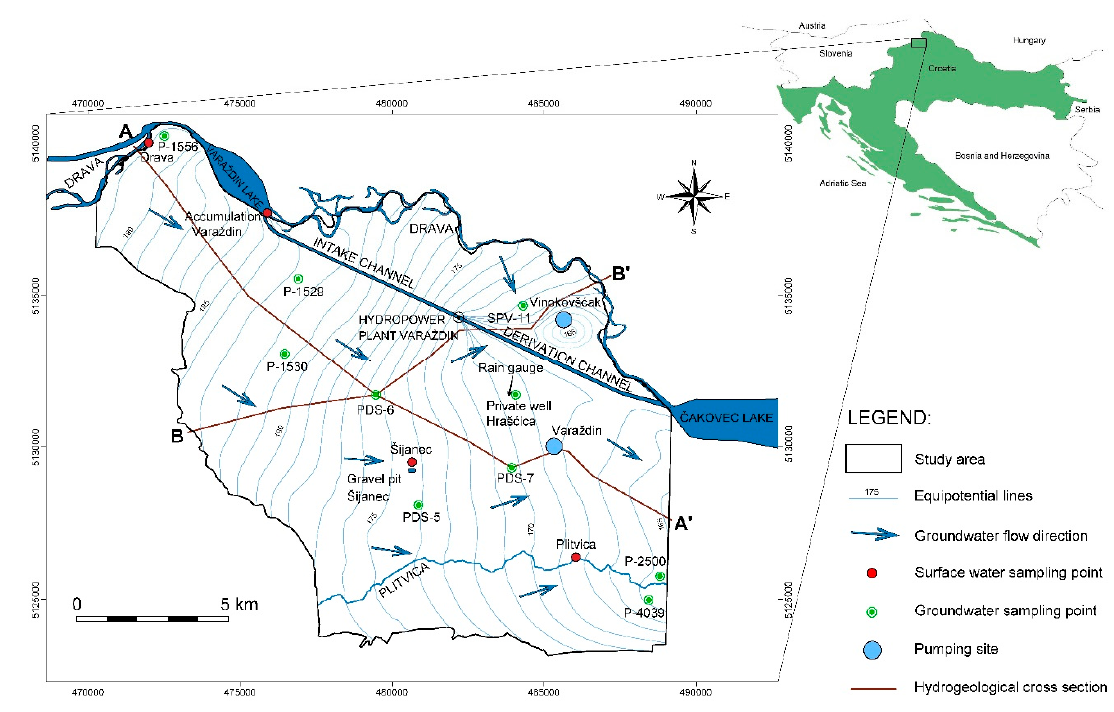
Figure 1. Geographical position of the study area with locations of the sampling points; the transects A–A’ and B–B’ correspond to the representative hydrogeological cross-sections shown in Figure 2. The general groundwater flow direction is defined by the water heads and stable isotopes in the study area.